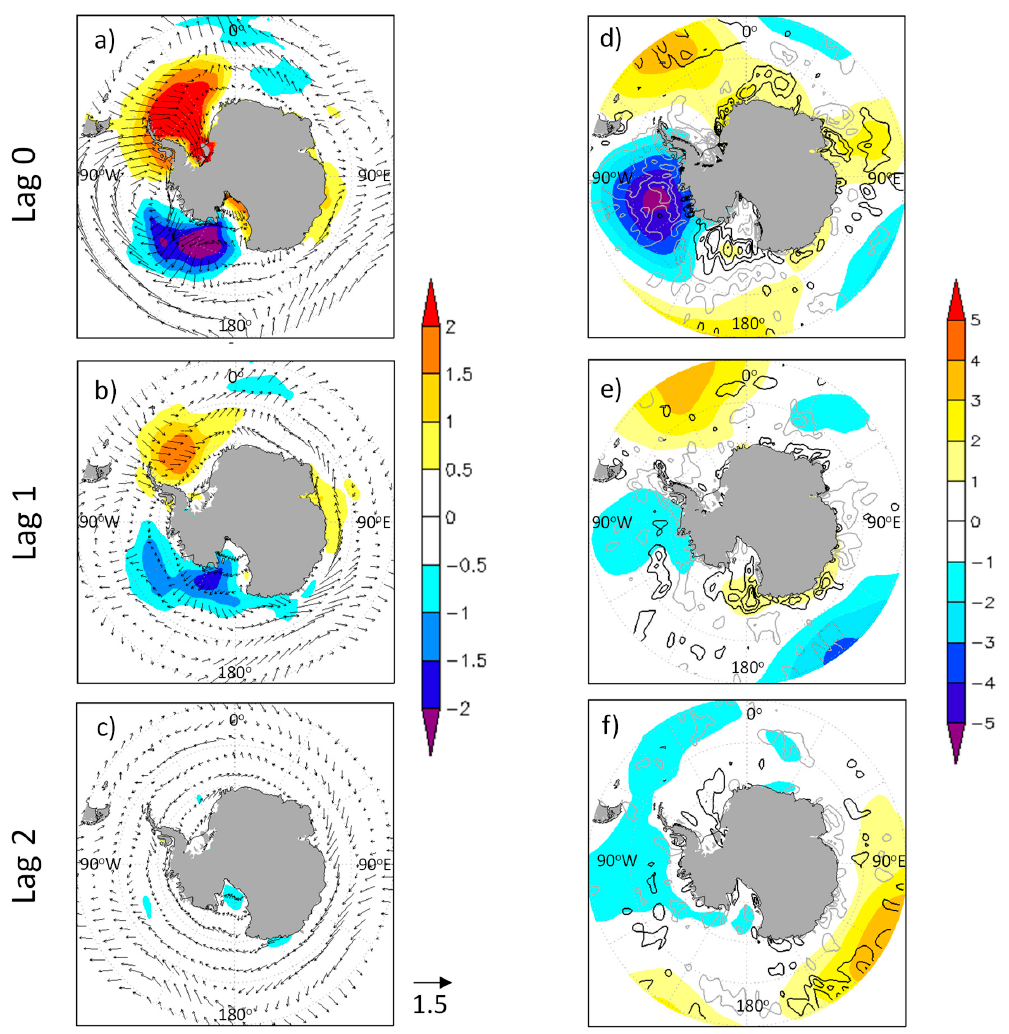
Figure 11. ( a – c ) Air temperature ( ◦ C) and horizontal wind (vectors with scale in the bottom, m s − 1 ) at 1000 hPa, ( c – e ) sea level pressure (hPa) and 1000 hPa wind divergence (x10 − 5 s − 1 with positive / negative values in black / gray lines) anomalies for high moisture sink composites (P80) in September (lag-0) ( a , d ), October (lag-1) ( b , e ) November (lag-2) ( c , f ). Table 3 indicated a preference for high moisture sink events (P80) in the SAM positive